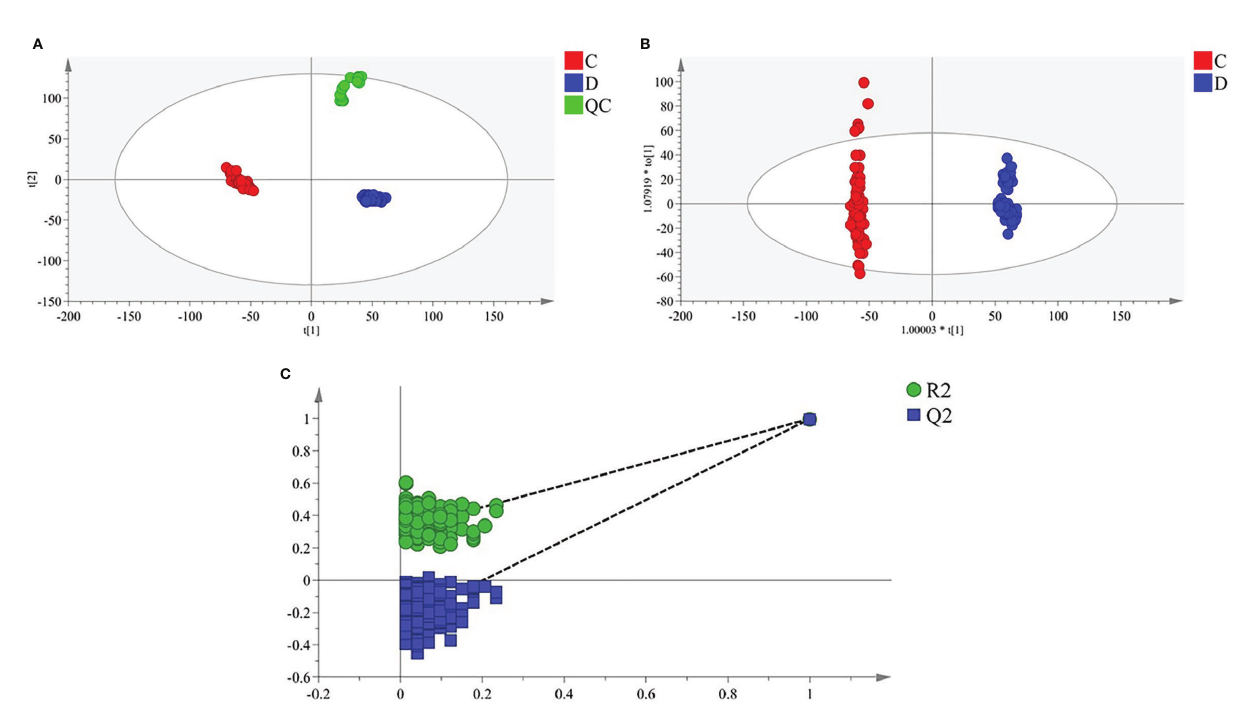
FIGURE 1 | Multivariate statistical analysis of two groups. The principal component analysis (PCA) plot of QC and samples in (A) positive ion mode. The orthogonal partial least square discrimination analysis (OPLS-DA) score plots of preoperative group vs. postoperative group in (B) positive ion mode. Cross-validation plot with a permutation test repeated 200 times of preoperative group vs. postoperative group in (C) positive ion mode. C, preoperative group; D, postoperative group; QC, quality